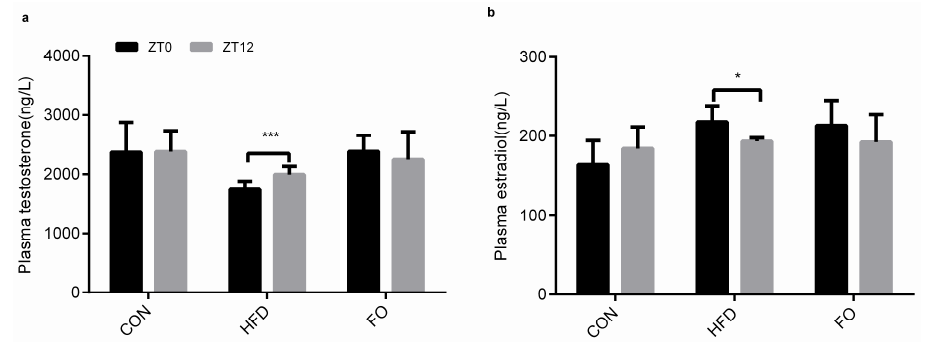
Figure 6. Effect of HFD and FO on the contents of T ( a ) and E2 ( b ) in plasma between morning (zeitgeber time 0, ZT0) and night (zeitgeber time 12, ZT12) variation. Data were expressed as mean ± SD ( n = 10 per group). * p < 0.05, *** p < 0.001.